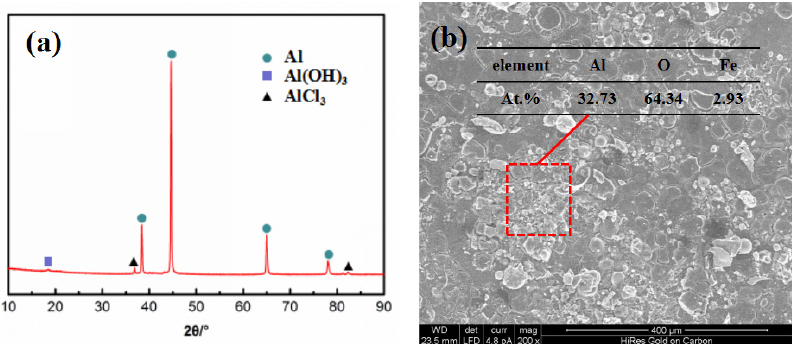
Figure 4. Images of corrosion products of the 7075 alloy after exposure for 6 months in the marine atmospheric environment: ( a ) XRD, ( b ) SEM morphology, and EDS result.